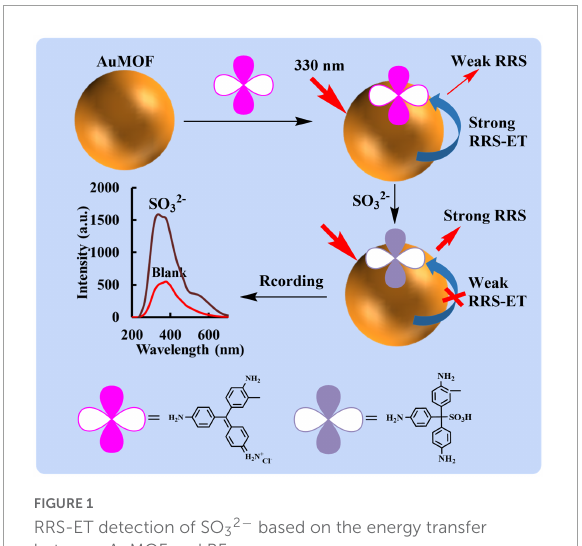
FIGURE1 RRS-ET detection of SO 32 − based on the energy transfer between AuMOF and BF.